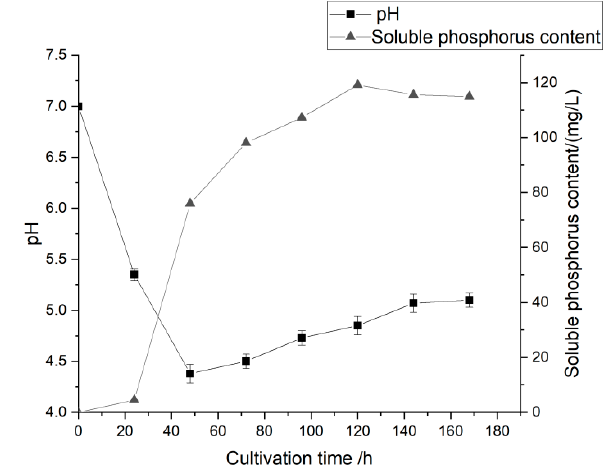
Figure 3. Changes of pH value and phosphate-solubilizing capacity in liquid culture of PSF7.